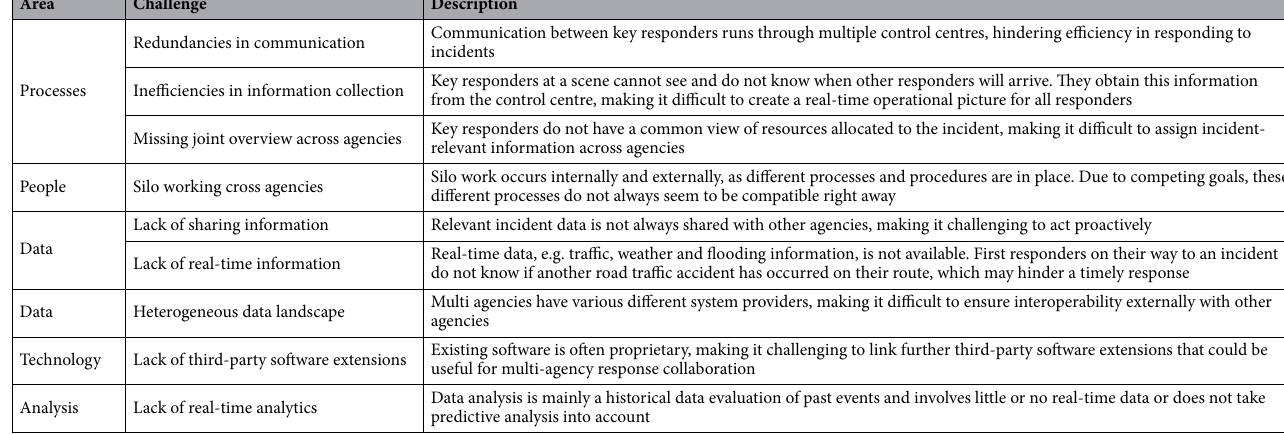
Table 1. Challenges in multi-agency response (own table, based on discussions held with stakeholders listed in subsection Identifying stakeholder needs). The table organises the identified stakeholder needs into the areas: Processes, People, Data, Technology, and Analytics. Each area lists the current challenges and describes them in more